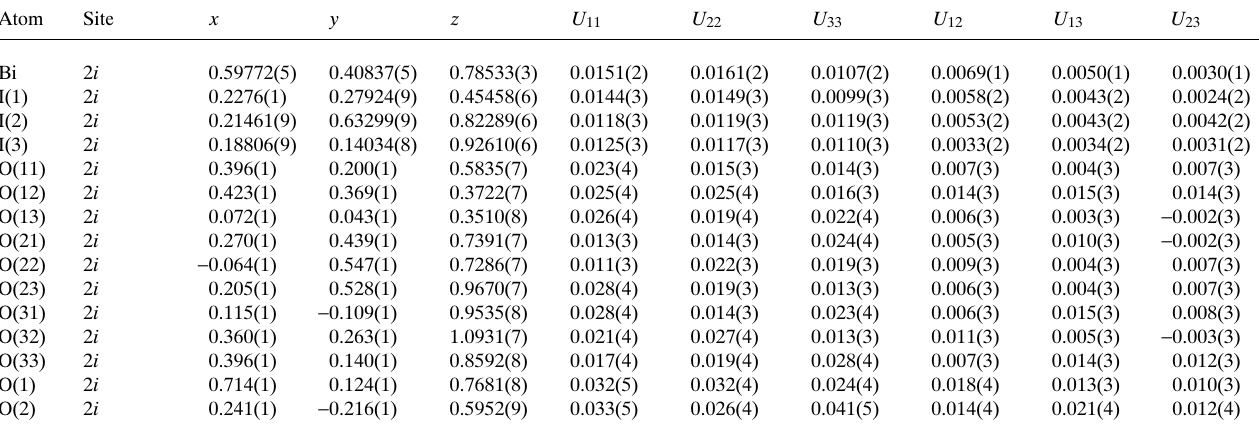
Table 2. Atomic coordinates and displacement parameters (in Å 2 ) .